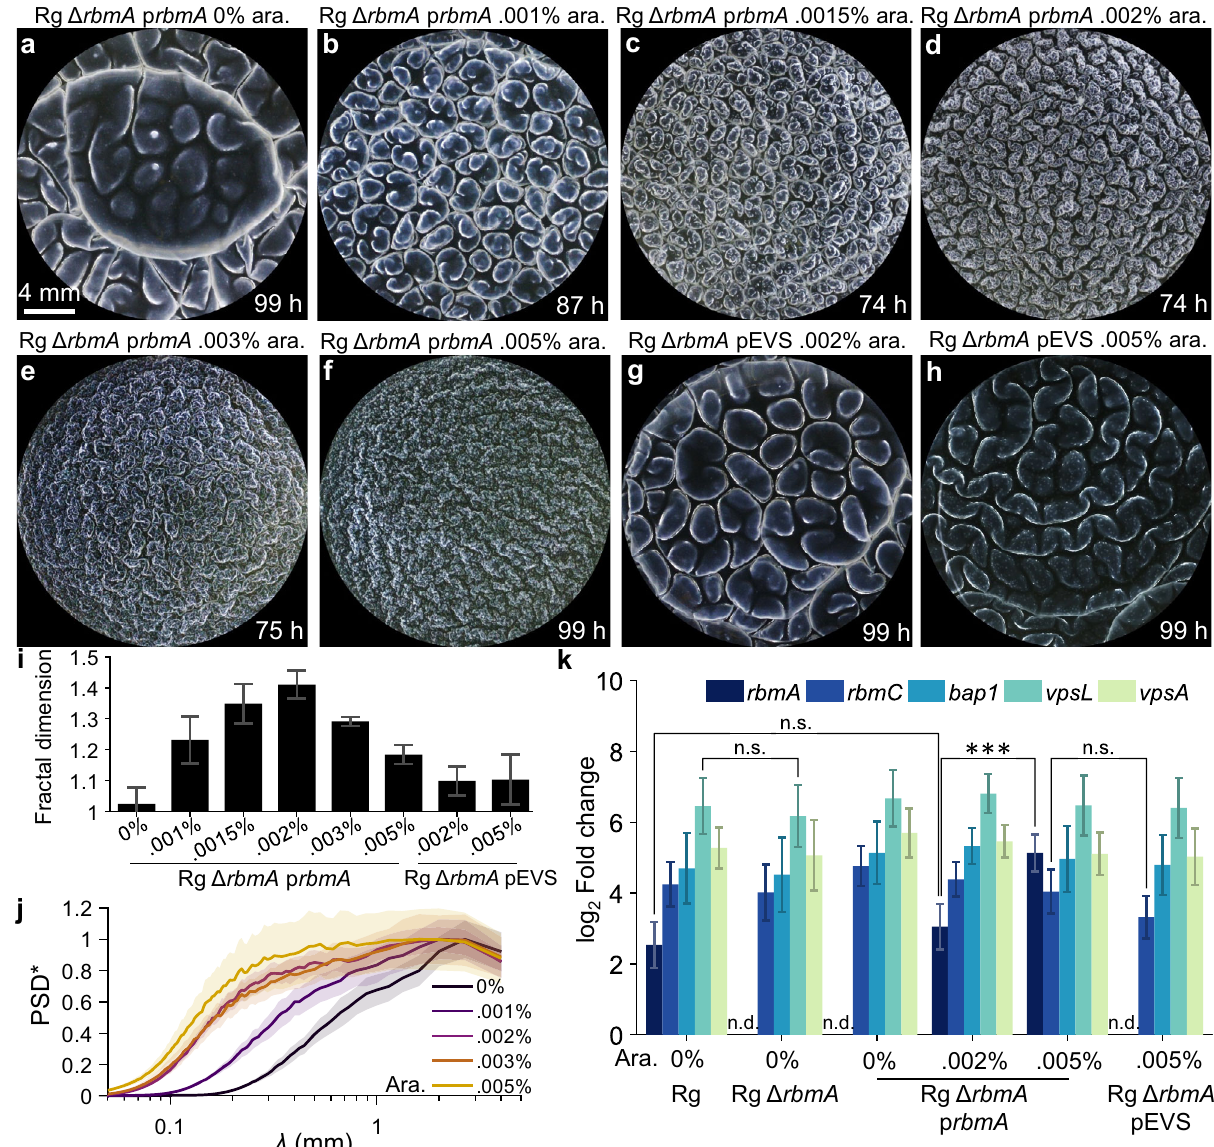
Fig. 3 | Induction of rbmA expression restores fractal wrinkling to V. cholerae Δ rbmA pellicles.a – f PelliclemorphologiesoftheRg Δ rbmA strainexpressing rbmA from the pEVS143 vector (designated p rbmA ) at the indicated arabinose inducer concentrations. g – h Pellicle morphologies of the Rg Δ rbmA strain carrying the empty pEVS143 vector (denoted pEVS) at the designated arabinose inducer con- centrations. i Fractal dimensions of the wrinkle features for the Rg Δ rbmA strain carrying p rbmA or the empty pEVS vector at the designated arabinose inducer concentrations and at the time points shown in a – h , at which plateau values of fractal dimensions had been reached. The bars correspond to the images in a – h . Errorbarsdenotestandarddeviationsofbiologicalreplicates( n =3). j Distributions